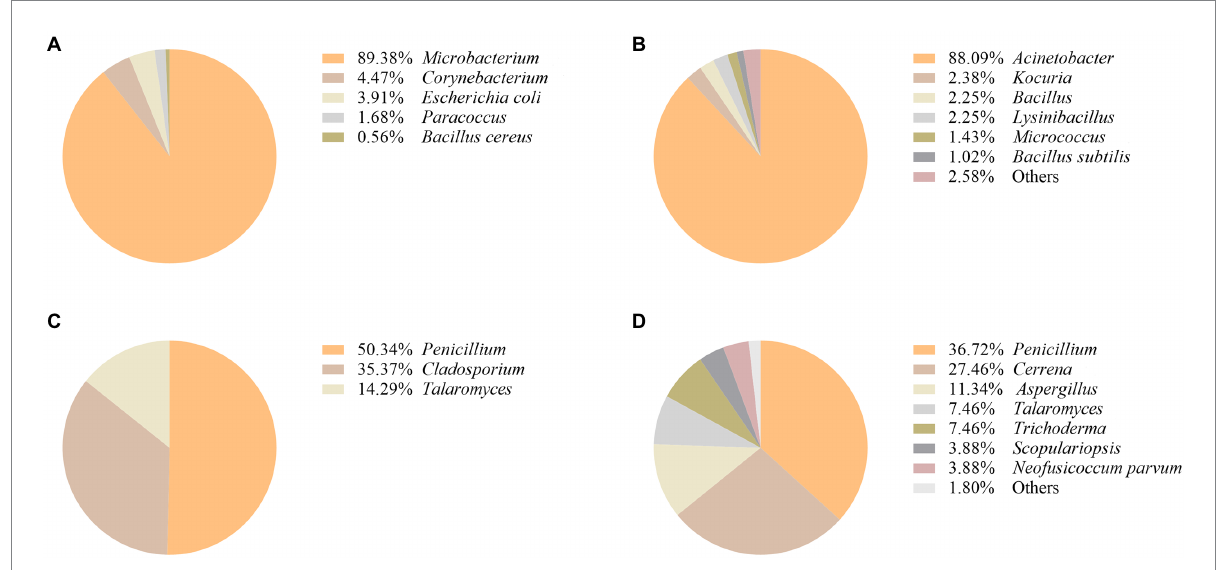
FIGURE 3 Composition of airborne bacterial communities in the protected environment of Nanhai No.1 shipwreck in 2019 (A) and 2020 (B) . Composition of airborne fungal communities in the protected environment of Nanhai No.1 shipwreck in 2019 (C) , and 2020 (D)